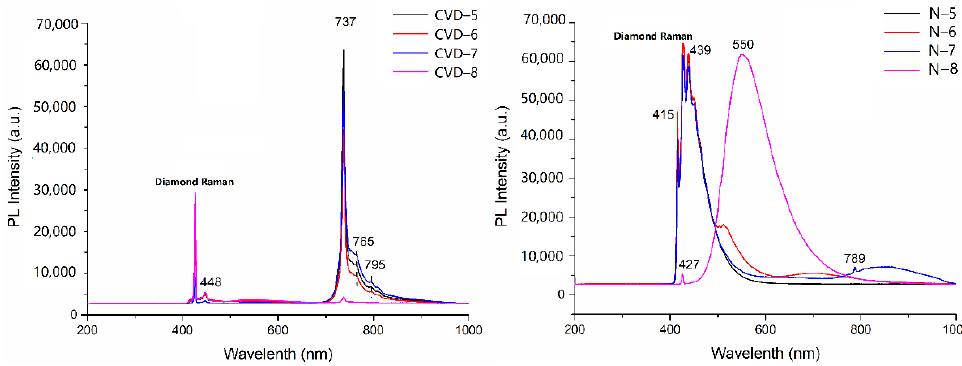
Figure 7. PL spectra of low color grade (H–K) diamond samples.